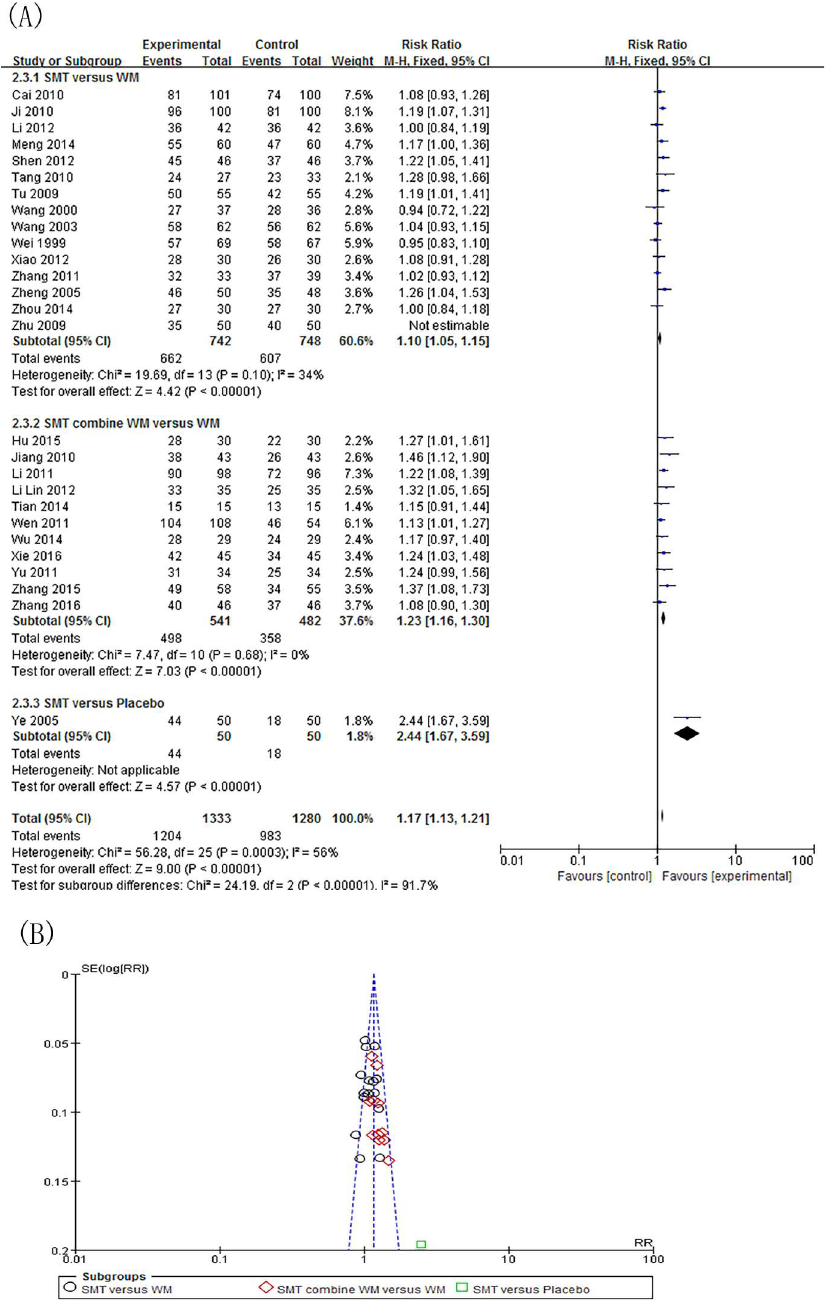
Fig 3. Efficacy rate and publication bias of SMT-treated FD after subgroup of SMT alone or combine with WM versus placebo or WM and sensitivity analysis. (A)Forest plot of comparison: the efficacy rate of symptoms. (B) Funnel plot of publicationbias of the includedstudies. SMT = Si-Mo-Tangoral liquid, WM = western medicine,FD =